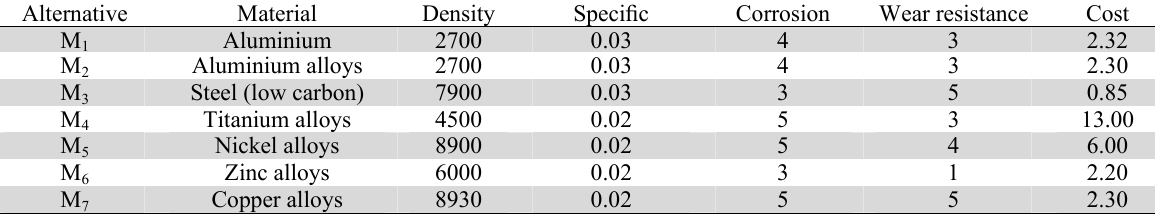
Data for load wagon wall material selection problem (Findik & Turan, 2012) Alternative Material